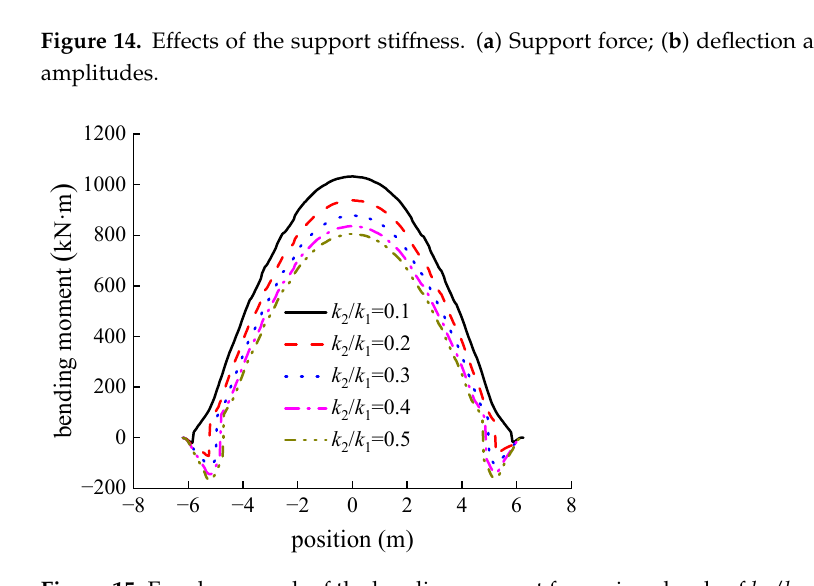
Figure 15. Envelope graph of the bending moment for various levels of k 2 / k 1 .